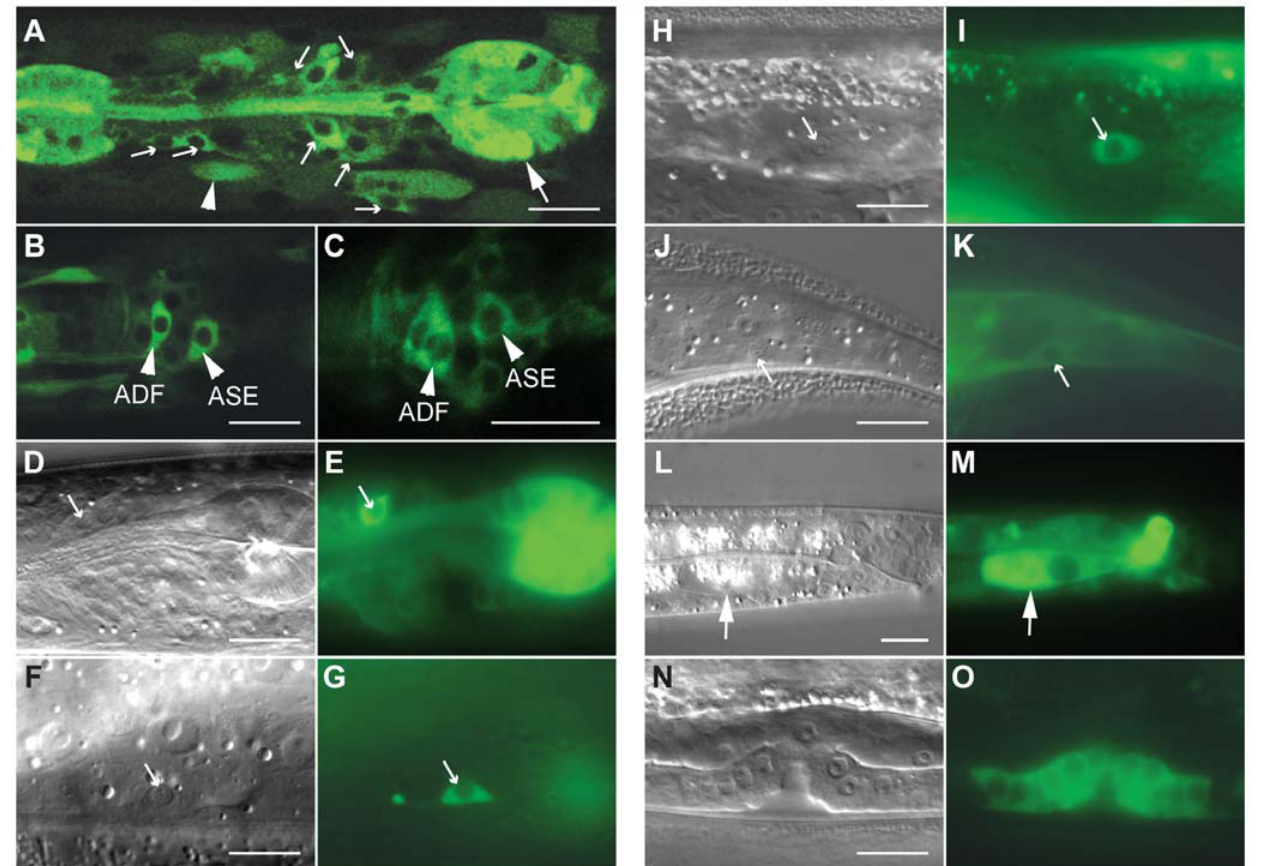
Figure 3. ELPC-1 is differentially expressed in C.elegans . (A–C) Confocal fluorescence micrographs of an hermaphrodite of the genotype elpc- 1(tm2149) ; svEx557 [P elpc-1 ::elpc-1::gfp ]. The large arrow in A denotes the posterior bulb of the pharynx. The smaller arrows denote sensory neurons in the head. The arrowhead indicates a body muscle. In B and C, specific sensory neurons in the head are indicated. (D–O) Micrographs of elpc- 1(tm2149) ; svEx557 [P elpc-1 ::elpc-1::gfp ] worms viewed with either Nomarski differential contrast (DIC) (D,F,H,J,L,N) or fluorescence (E,G,I,K,M,O) optics. The arrows in D and E indicate an ASK sensory neuron; in F and G, an HSN; in H and I, a CAN cell; in J and K, a PLM neuron; in L and M, a cell in the intestine. The green fluorescence in O is from cells in the developing vulva. Scale bars denote 10 microns.